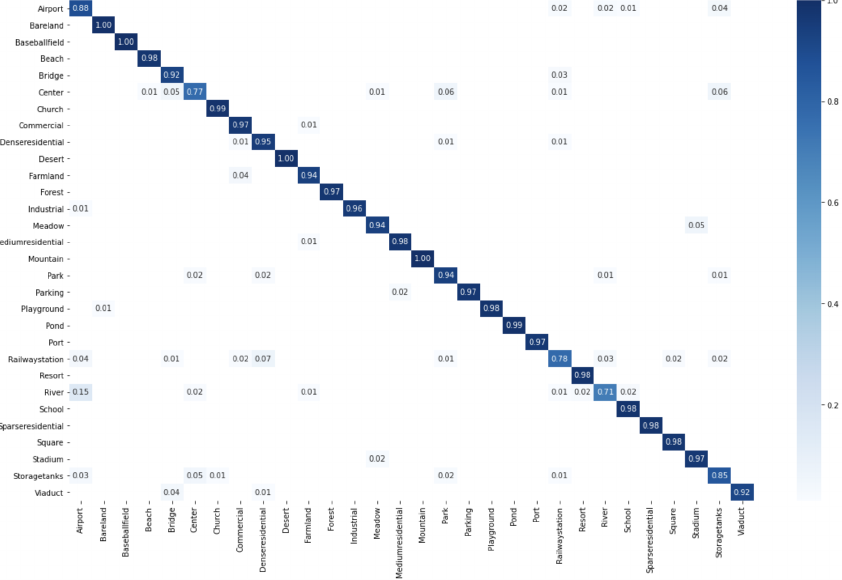
Figure 12. Confusion matrix of our method under the 20% training ratio and 90% of important features on the AID data